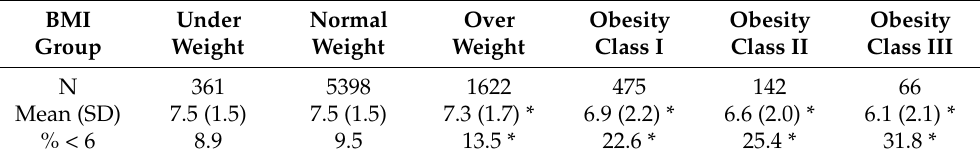
Table 1. Momentary perceived immune fitness according to BMI group.